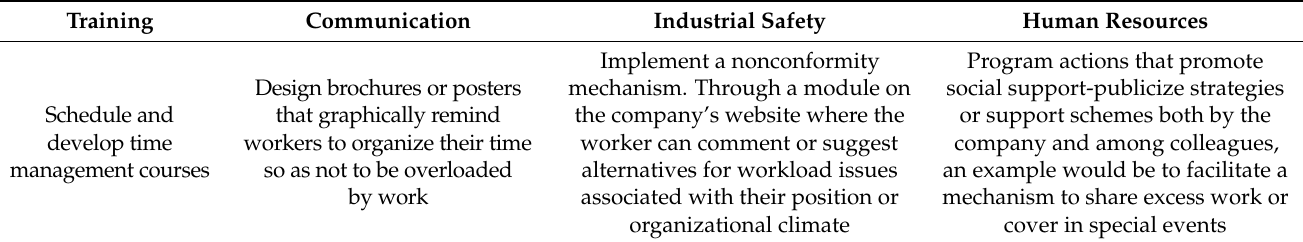
Figure 3. Risk level of five organizational psychosocial risks. Table 2. Actions by department for the work time management risk.